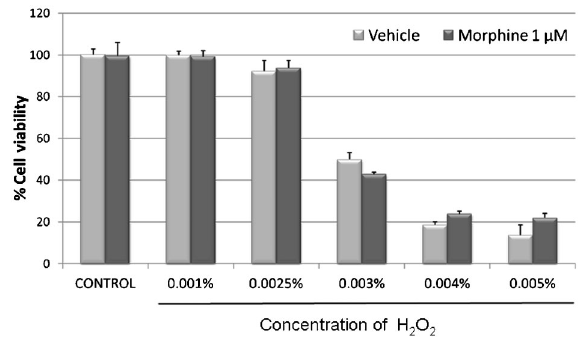
Figure 1. Cell viability of C6 cell line exposed to increasing concentrations of hydrogen peroxide (H 2 O 2 ) and/or 1 m M morphine for 24 h. Data are reported as means±SE. No significant differences were detected in groups incubated with the same concentration of H 2 O 2 (ANOVA).